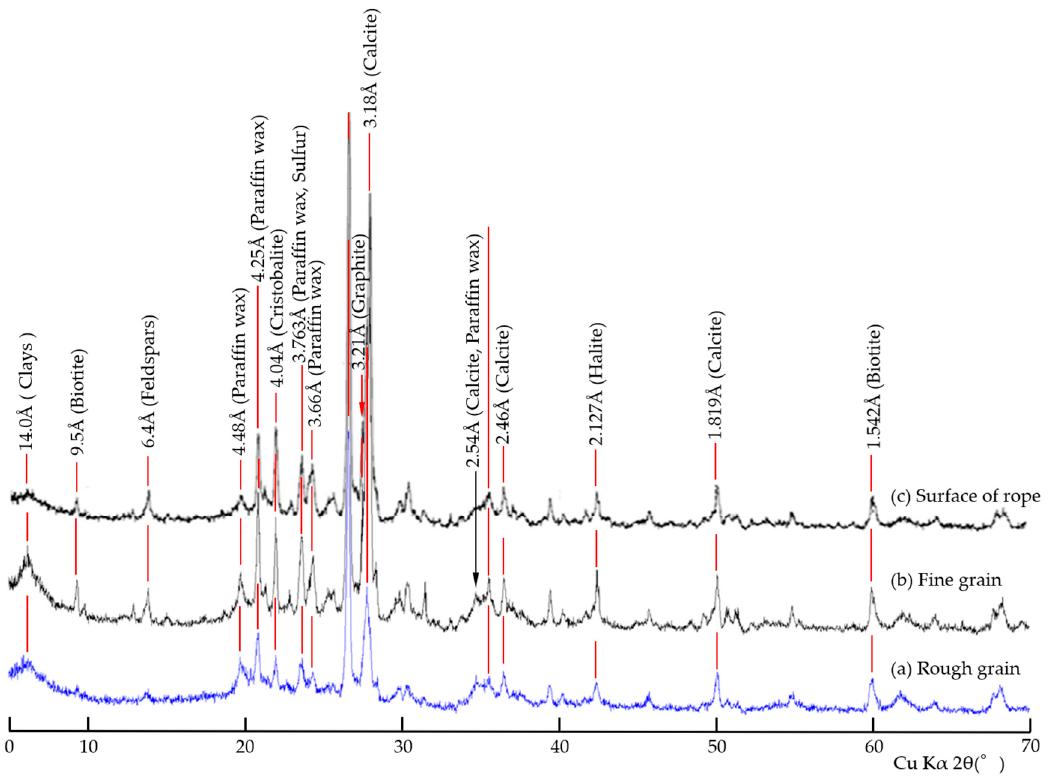
Figure 3. XRD analyses of the contaminated soils with oil divided into the rough grain portion ( a ), the fine grain portion ( b ), and the oily surface of the rope ( c ) at the Atake seashore, indicated paraffin wax, graphite, sulfur, calcite, and halite refractions associated with clay minerals in the oily soils after 20 years.